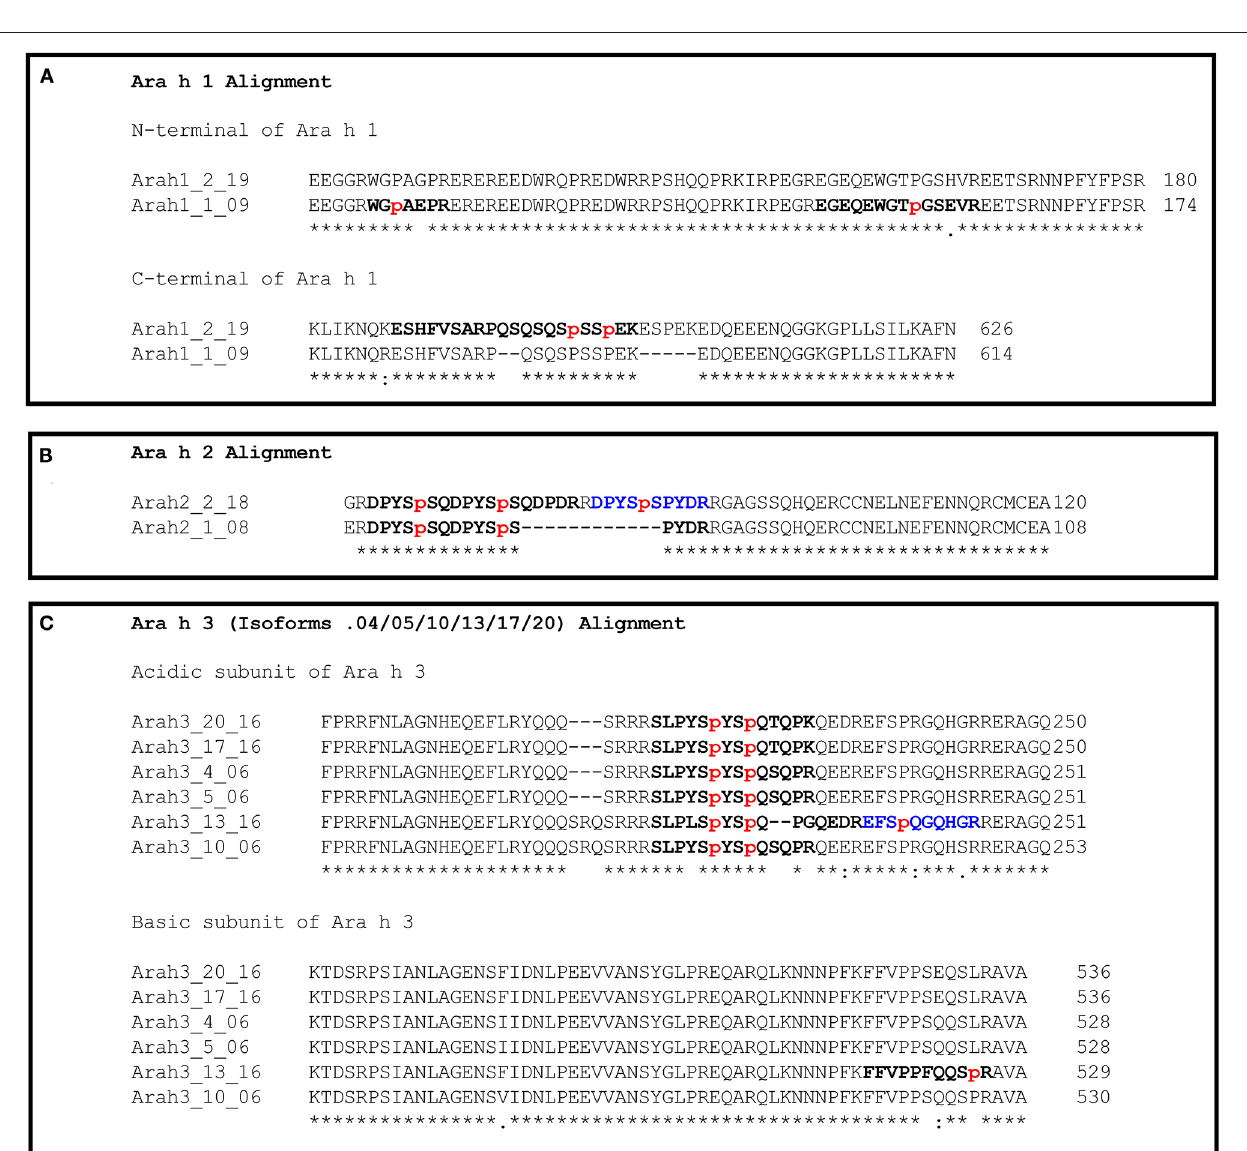
FIGURE 5 | Sites of hydroxyproline-rich regions of Ara h 1, 2, and 3. The most abundant HyP-modified tryptic peptides detected are bolded. The sites of HyP are shown in lower case and colored red (refer to Supplementary Table S6 ). (A) shows the predominant sites of HyP modification in Ara h 1. (B) shows the predominant sites of HyP modification in Ara h 2. (C) shows the predominant sites of HyP modification in Ara h 3. Alignment was conducted using Clustal Omega